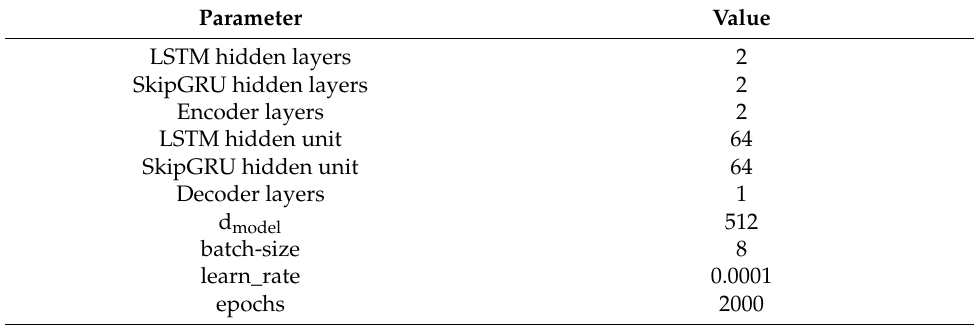
Table 1. Model parameter setting.